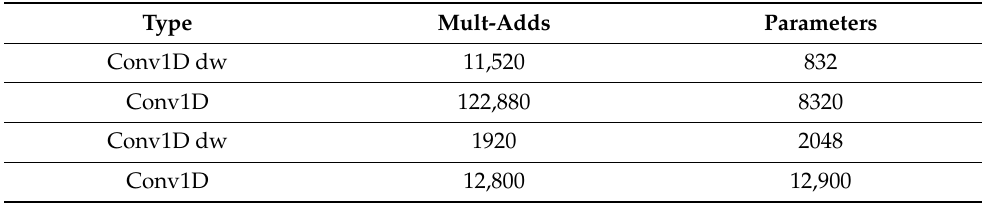
Table 3. The resource per depthwise separable